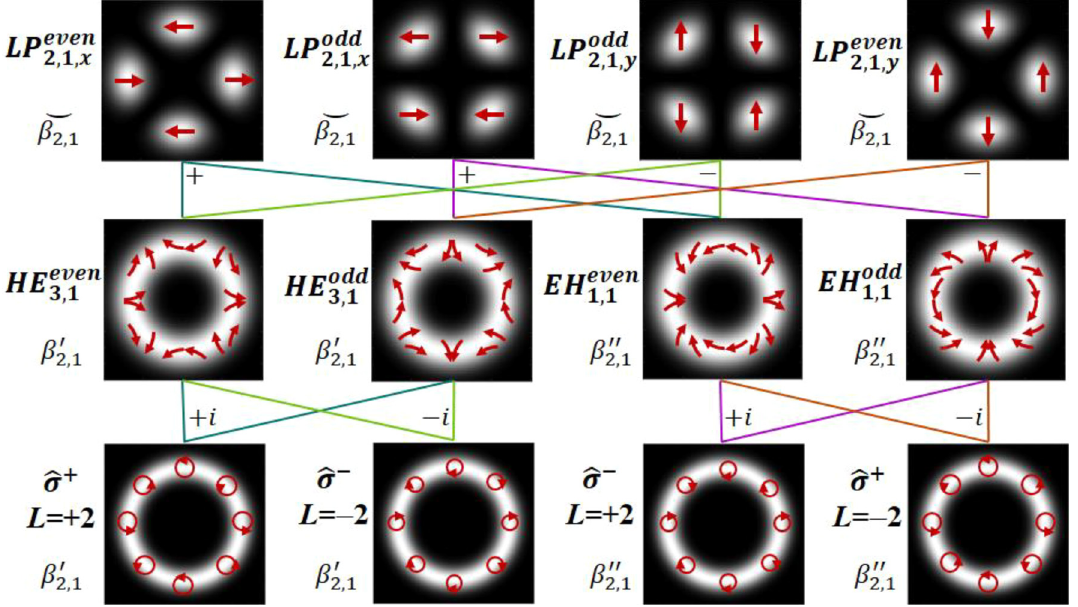
Figure 2: Intensity and polarization patterns of linearly polarized (LP) (top row), vector (middle row), and orbital angular momentum (OAM) modes (bottom row) with azimuthal index | L | = 2 and radial index m = 1. Colored lines show linear combinations between groups. The + i or − i terms represent a π /2 or − π /2 phase shift in the linear combinations. As described in the caption of Figure 1, azimuthal shifts of the arrows on the OAM modes indicate an azimuthal phase shift. The propagation constant is β ′ corresponding HE modes), and β ′′ for SOaa modes (and the corresponding EH modes). The propagation constant of the LP designation is 2 , 1 (cid:2) β , which is an average of β ′ and β ′′ 0 , m 2 , 1 2 , 1